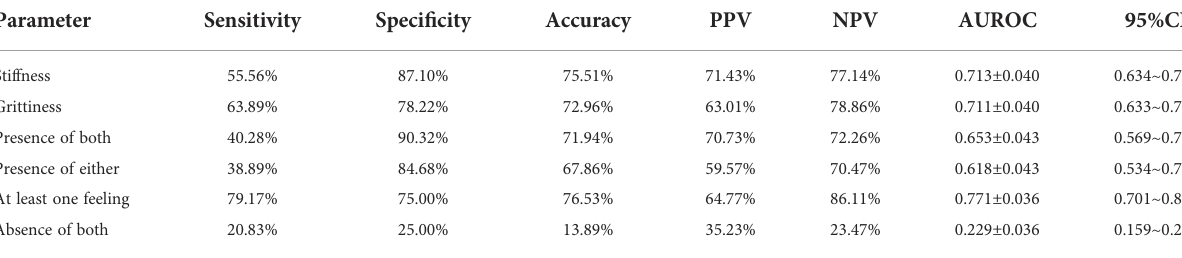
TABLE 3 Diagnostic performance of puncture feeling for thyroid nodules with indeterminate FNA fi ndings.